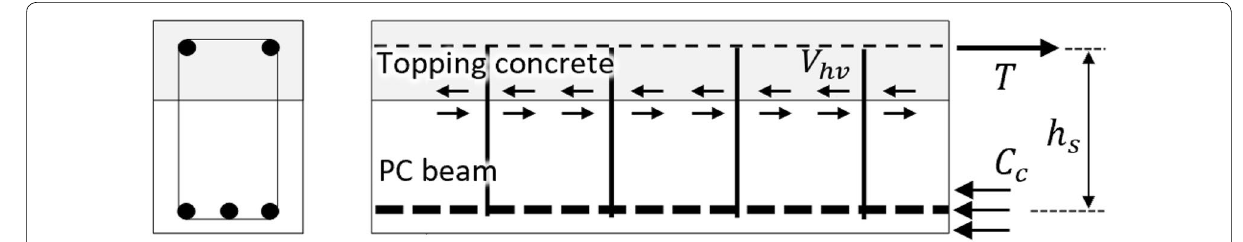
Fig. 5 Horizontal shear of PC